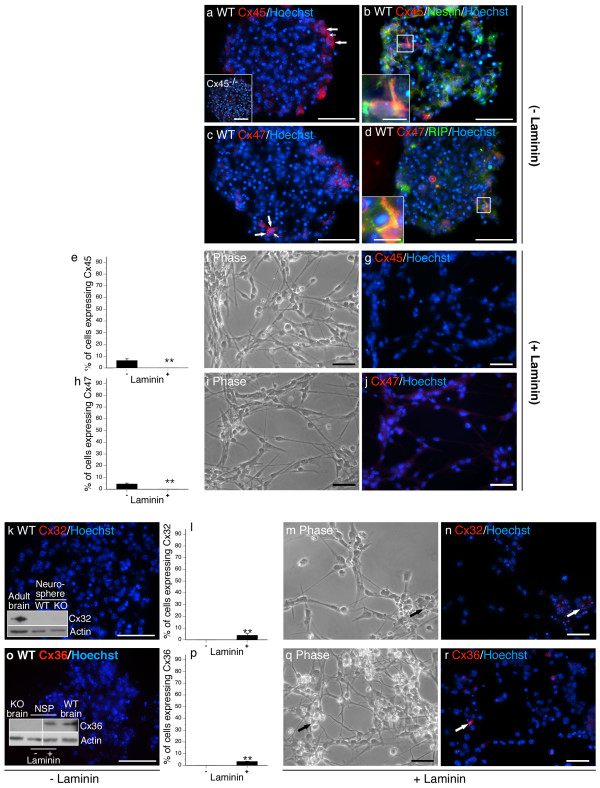
Cx32, Cx36, Cx45, and Cx47 are expressed by rare cells and are laminin-responsive. Cx45 (a, arrows) and Cx47 (c, arrows) were expressed in rare populations of cells. Cx45 was detected in Type 2a nestin+ cells (b, inset). Cx47 was restricted to RIP+ oligodendrocytes (d, inset). Both connexins were downregulated when plated on a laminin substrate (Cx45 e-g, Cx47 h-j). Cx32 (k) and Cx36 (o) protein was not detected in the absence of laminin but was induced following adherence to substrate (Cx32 (l-n) and Cx36 (p-r)). To confirm the lack of Cx32 protein in suspension cultures, western analysis was performed using adult WT brain as a positive control (k, inset). Similarly, western analysis was carried out to confirm Cx36 expression in the + laminin condition and to verify antibody specificity (p, inset). Adult WT and null-mutant (KO) brain served as positive and negative controls. Actin immunoblotting was performed as a loading control. Scale bars, 50 μm, Insets, 25 μm. **p < 0.01 Student's t-test.